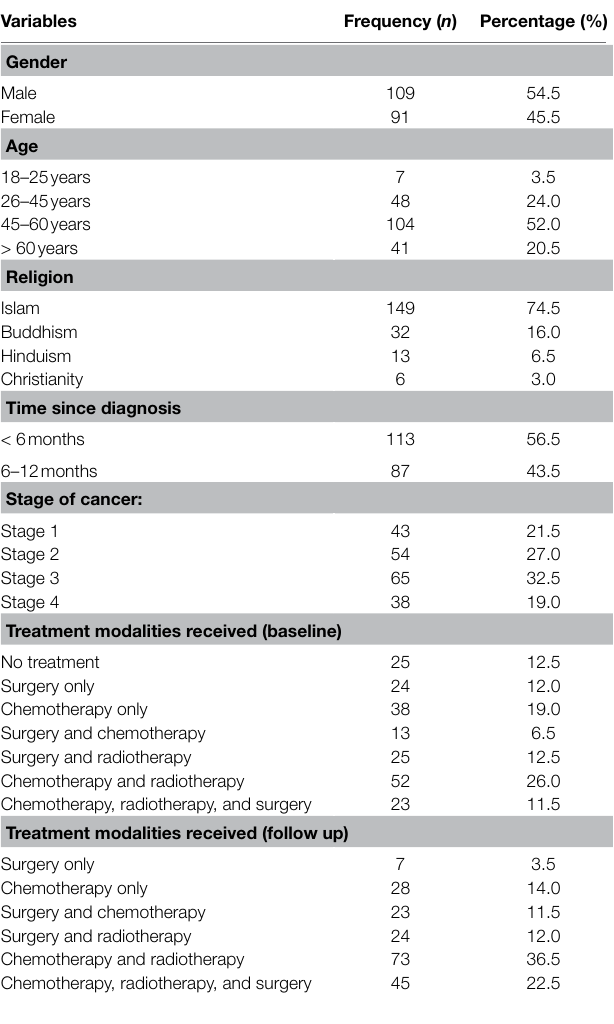
TABLE 1 | Socio-demographic and clinical characteristics of the